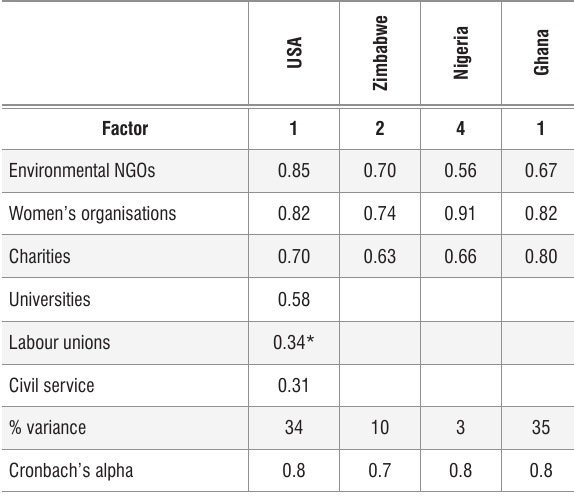
The not-for-profit cultural metric